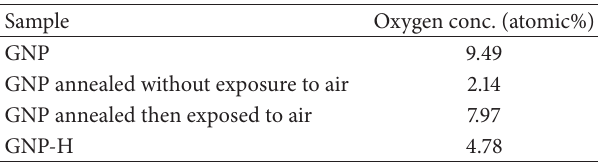
Table 1: Oxygen concentrations of graphene nanosheets after